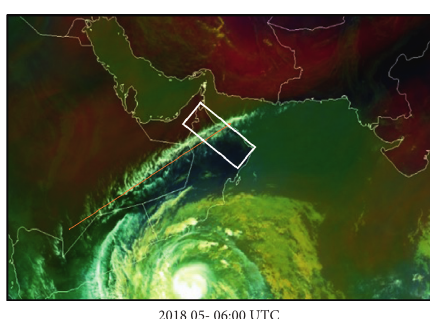
Figure 22: Airmass RGB (red: 6.2 μ m–7.3 μ m; green: 9.7 μ m–10.7 μ m; blue: 6.7 μ m) on 24 May